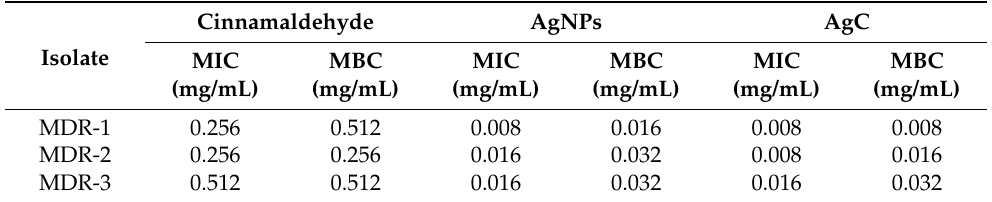
Table 1. Determination of MIC and MBC values of cinnamaldehyde, AgNPs and AgC against MDR-EAEC